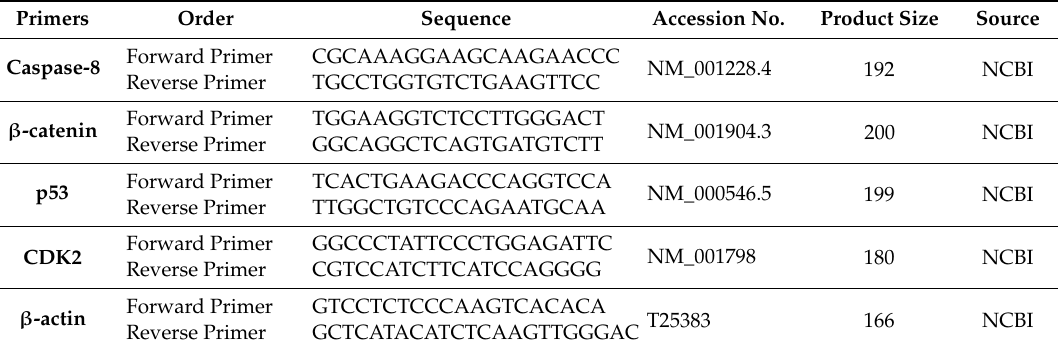
Table 1. Primers for cell signaling pathways gene expression